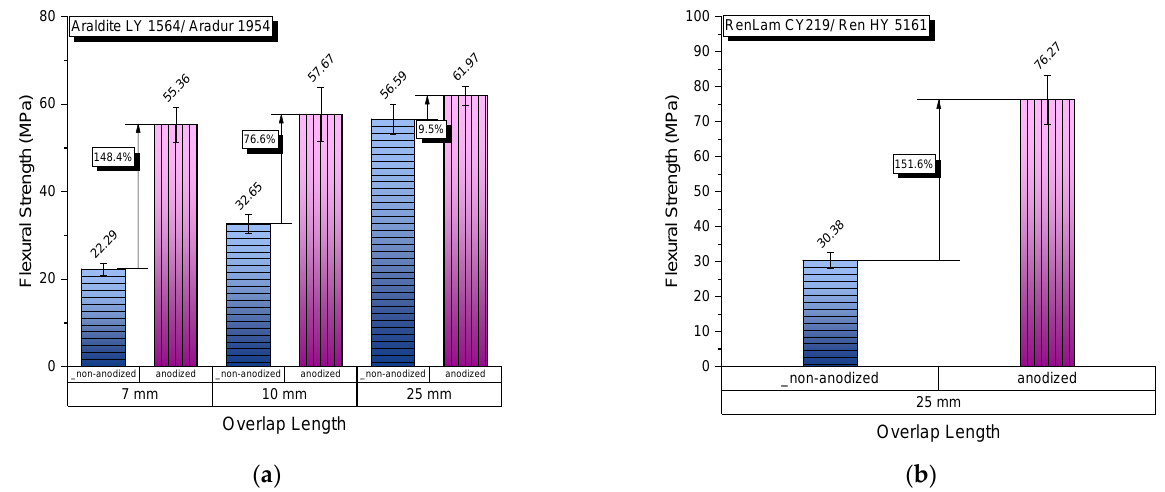
Figure 10. Comparative values of the mechanical properties of aluminum adhesive joints with non-anodized and anodized adherends: ( a ) flexural strength for Araldite adhesive; ( b ) flexural strength for RenLam adhesive.